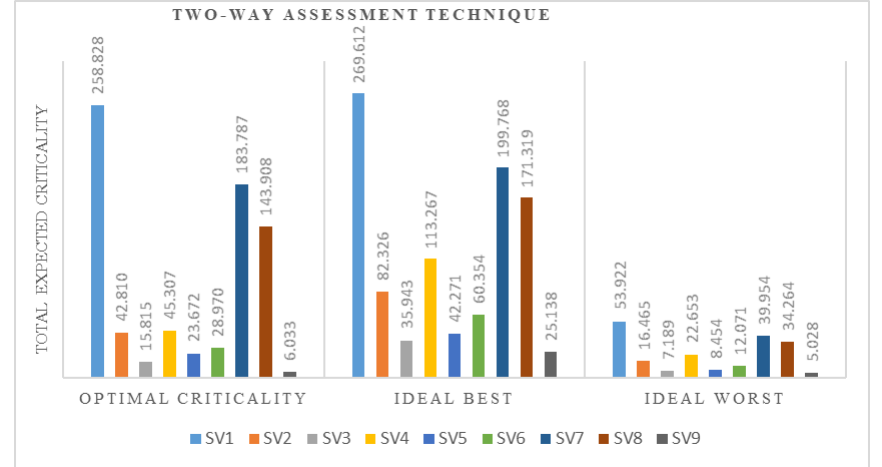
Figure 3. Graphical representation of ideal worst, ideal best and optimal values of